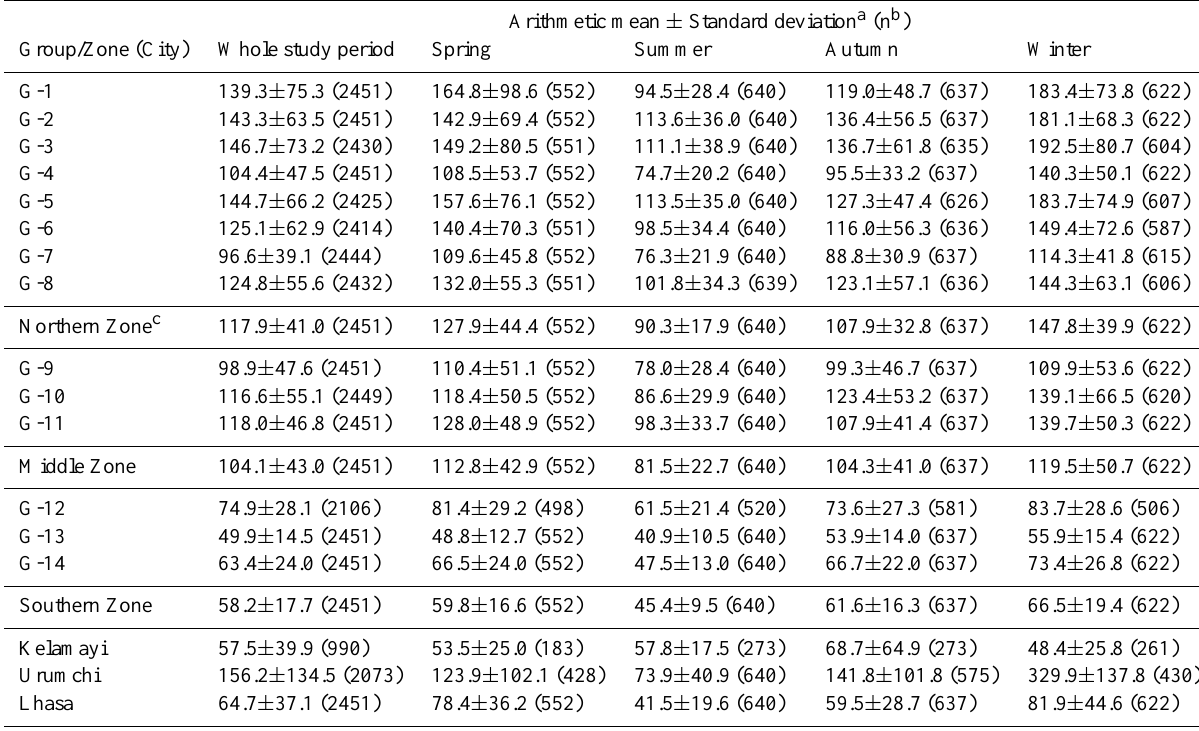
Table 4. Seasonal arithmetic mean PM 10 concentrations for the fourteen groups and three latitudinal